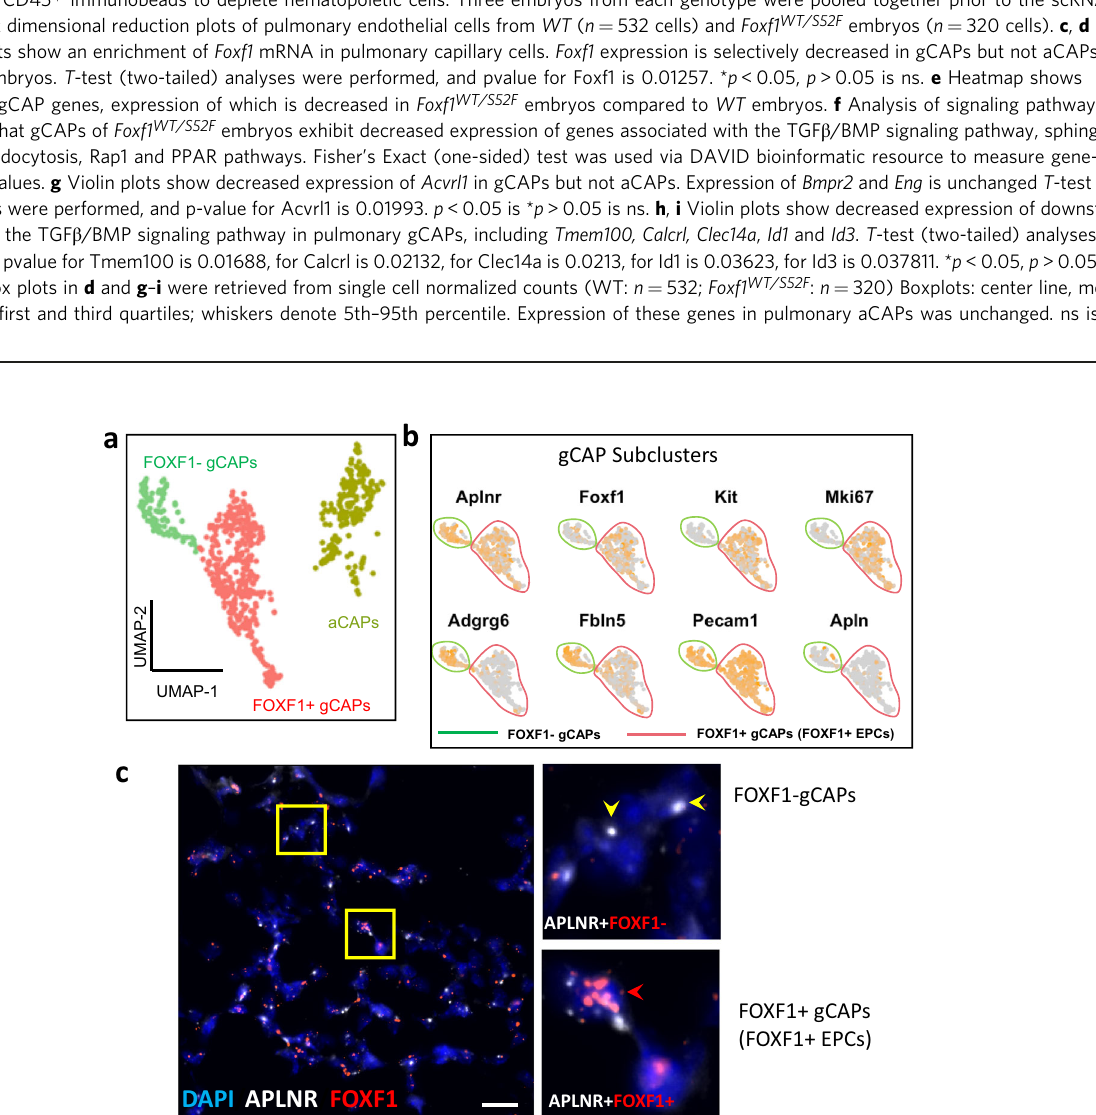
Fig. 3 FOXF1 is expressed in a subset of gCAPs. a , b Dimensional reduction plot with UMAP was generated using scRNAseq dataset from WT E18.5 lungs and shows gCAP and aCAP clusters of microvascular endothelial cells. Three embryos were pooled together prior to the scRNAseq analysis. gCAPs consist of two distinct subclusters: FOXF1 + gCAPs and FOXF1 – gCAPs. c RNAscope of lung sections from WT E18.5 embryos shows APLNR-expressing gCAPs in the alveolar region. High magni fi cation images of area in yellow box are shown on the right. Lung sections were counterstained with DAPI. APLNR co- localizes with FOXF1 in FOXF1 + gCAPs (red arrowheads). FOXF1 is not expressed in FOXF1 – gCAPs (yellow arrowheads). The RNAscope assays were performed twice with consistent results. Scale bars are 10 μ